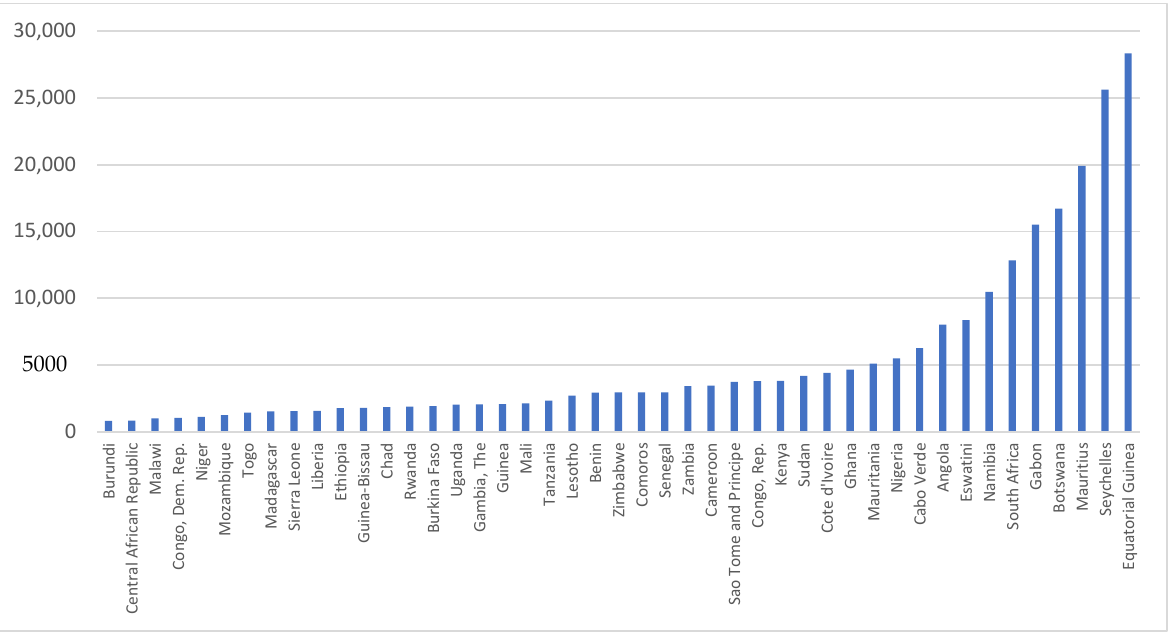
Figure 4. GDP per capita, 2000 – 2015. In column 2, we included renewable electricity production. As expected, the coefficient for renewable energy was negative and significant at the 1% level. If causal, a one per- centage point increase in renewable electricity output reduces carbon emissions by 0.22%. These results align with existing cross-country evidence [18] highlighting the importance of switching from fossil fuel energy to renewable energy consumption. We further include an interaction term between industry and renewable energy in Column 3. The interaction term is negative and significant, suggesting that the renewable energy sector is important to offset the negative effects of industrialization on CO 2 emissions. The coefficients in columns 1–3 change as we include additional variables and an interaction term between renewable energy and industrialization. The AR (2) and Hansen p -values confirm that our instruments are valid and reliable. The F-statistics exceed the threshold value of 10 confirming that overall; the econometric specification is significant in our